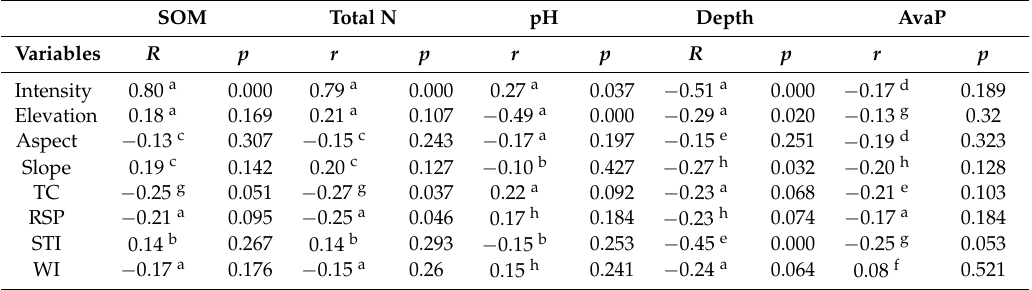
Table 2. Best result of Pearson correlation between multi-scale variables and topsoil properties. SOM Total N pH Depth AvaP Variables